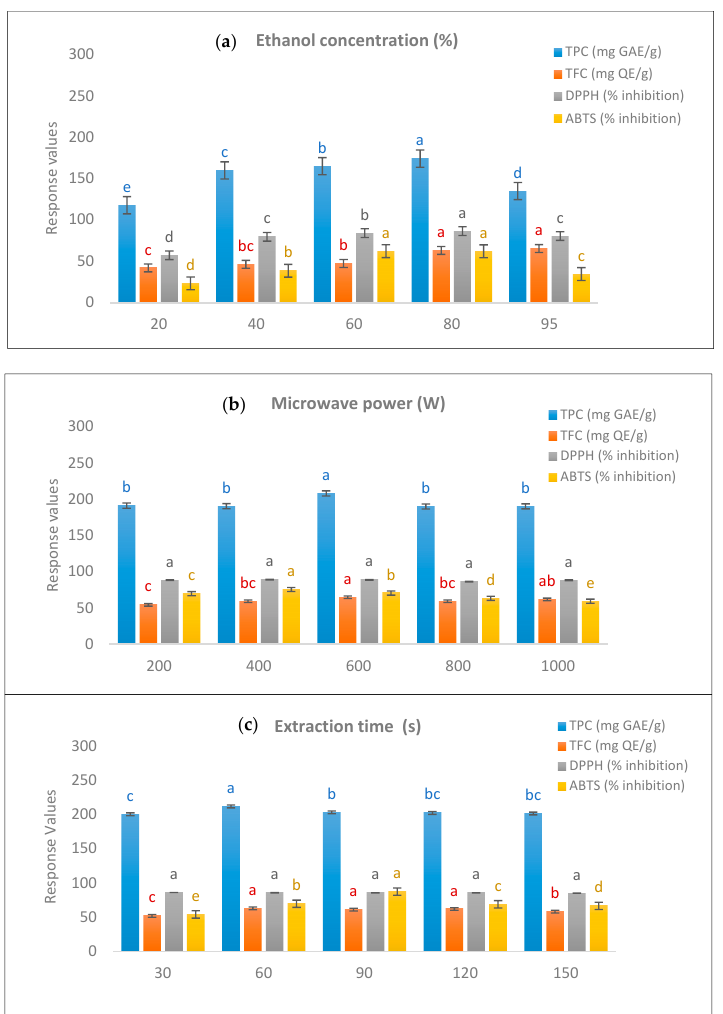
Figure 1. Effects of single factors: ( a ) ethanol concentrations, ( b ) microwave power, and ( c ) extraction time on total phenolic content (TPC), total flavonoid content (TFC), 1-diphenyl-2-picrylhydrazyl (DPPH), and 2,20-azino-bis (3-ethylbenzothizoline-6-sulfonic acid) (ABTS), respectively, of B. lupulina leaf extract. One-way ANOVA was used to compare the significant differences among groups. Different letters (a, b, c, d, and e) in blue, red, black, and yellow colors, respectively, represent significant differences ( p < 0.05) in TPC, TFC, DPPH, and ABTS values among groups. The same letter indicates no significant difference ( p > 0.05) among